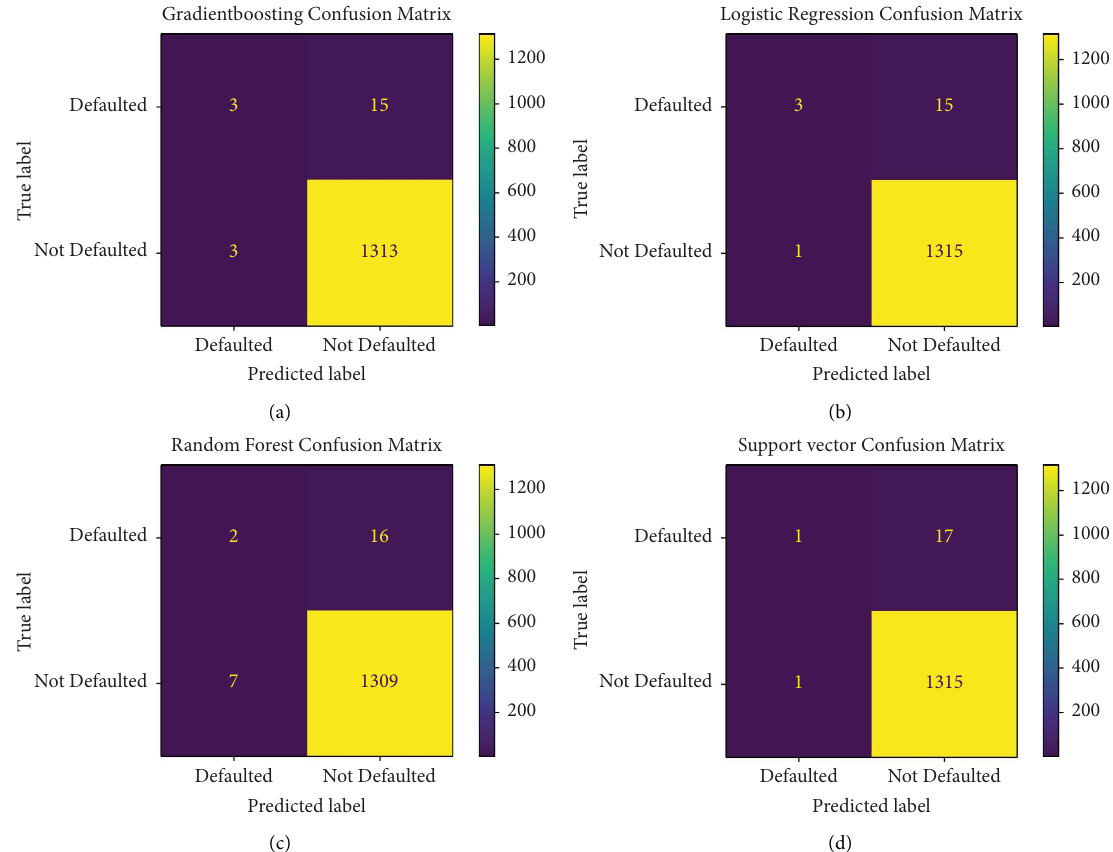
Figure 8: Model confusion matrices for (a) gradient boosting, (b) logistic regression, (c) random forest, and (d) support vector machine. nondefaulters. In Figure 8(b), logistic regression correctly classifed 1315 patients as nondefaulters and misclassifed 15